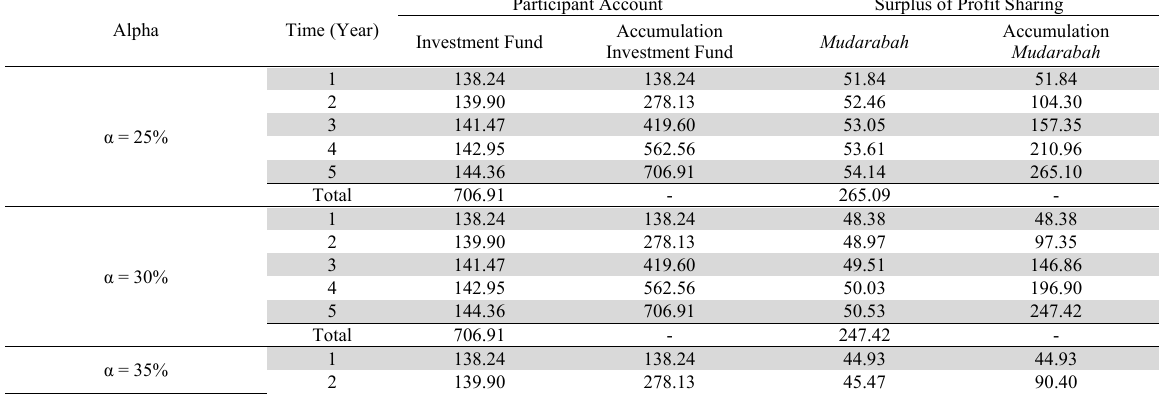
The value of participant account at the inception of insurance under equity-linked